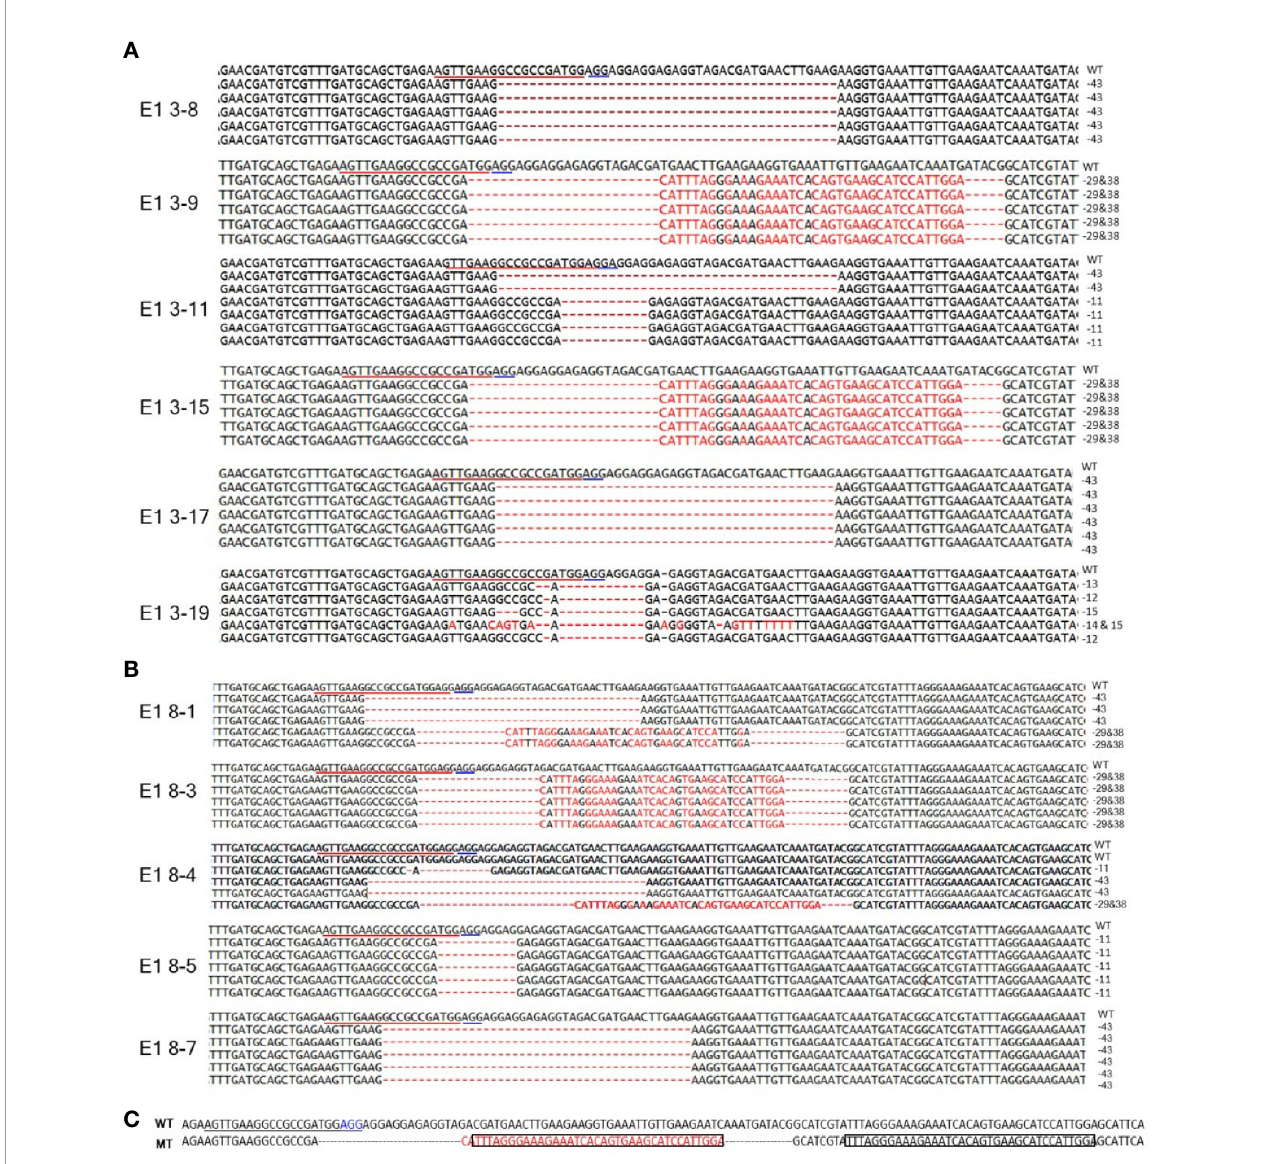
FIGURE 4 | Genome-edited sequences of eIF4E1 from E 1 transgenic lines. (A, B) DNA sequences of the eIF4E1 mutant lines derived from E0-3 (A) and E0-8 (B) . (C) Insertion of a 38-bp repeat sequence (boxed) from sgRNA adjacent region. The sgRNA target sequence is underlined in red and the PAM motif in blue. WT, wild type; MT, mutant lines (E1 3-9, E1 3-15, E1 8-1, and E1 8-3).